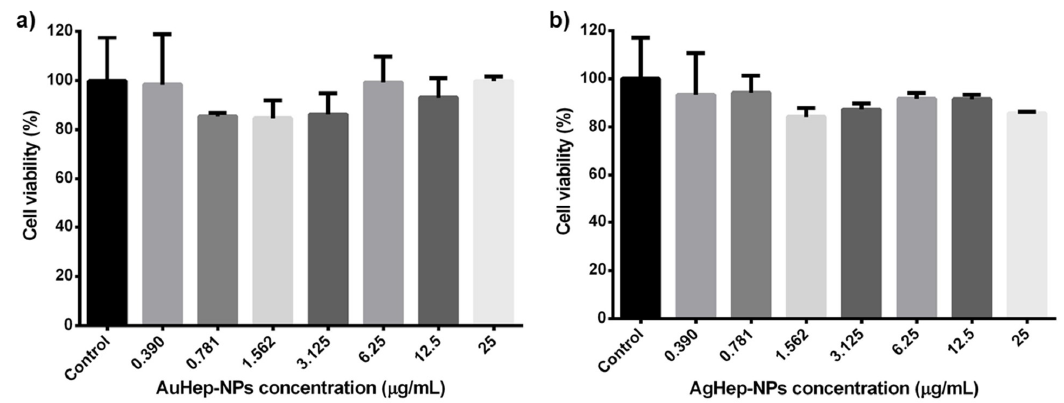
Figure 4. In vitro cytotoxic assay for heparin-based ( a ) AuHep-NPs and ( b ) AgHep-NPs,